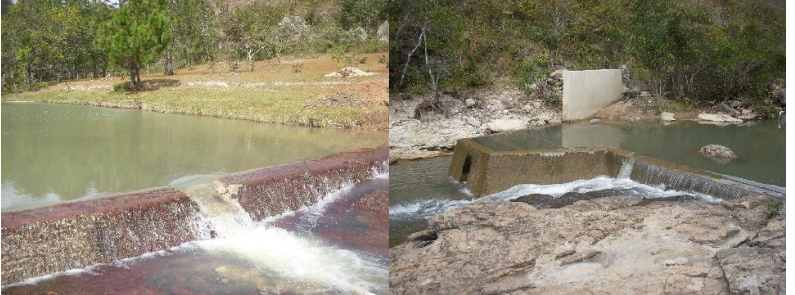
Figure 4. Small dam construction in La Estanzuela, La Paz, Honduras: existing ( left ) and new ( right ) construction (Photo Credit: F. M. Tehrani 2011).